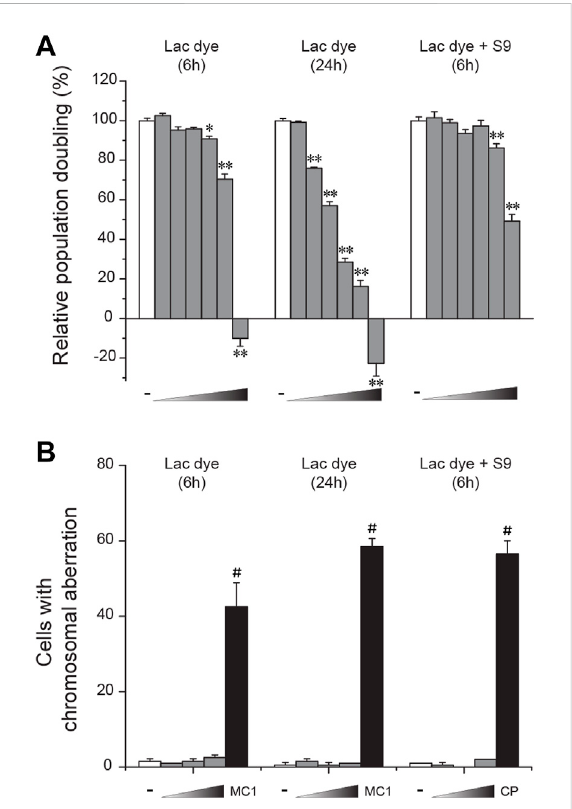
FIGURE 3 Lackofmutagenicityinlacdyeshownbythebacterialreverse mutationtest.Lacdye(LD)wastreatedonfour S.typhimurium and one E. coli tester strains for assessment of mutagenicity. Up to 5000 μ g/plateofLDdidnotincreasethenumberofrevertant colonies regardless of metabolic activation by the S-9 mixture, while the respective positive controls resulted in a signi fi cant increase. White bars, vehicle control; gray bars, lac dye (312.5, 625, 1250, 2500, and 5000 μ g/plate from the left); and black bars, positive controls (NF, 10.0 μ g/plate 2-nitro fl uorene; SA1, 5.0 μ g/ plate sodium azide; MS, 2.5 μ g/plate methylmethane sulfonate; SA2, 0.5 μ g/plate sodium azide; 9AA, 80.0 μ g/plate 9- aminoacridine; AA1, 2.0 μ g/plate 2-aminoanthracene; and AA2, 5.0 μ g/plate 2-aminoanthracene). Negative signs indicate the vehicle control, and right-angled triangles with gradient shade, increasing doses of LD. * p < 0.05 by one-way ANOVA, followed by post hoc Dunnett ’ s t -test.